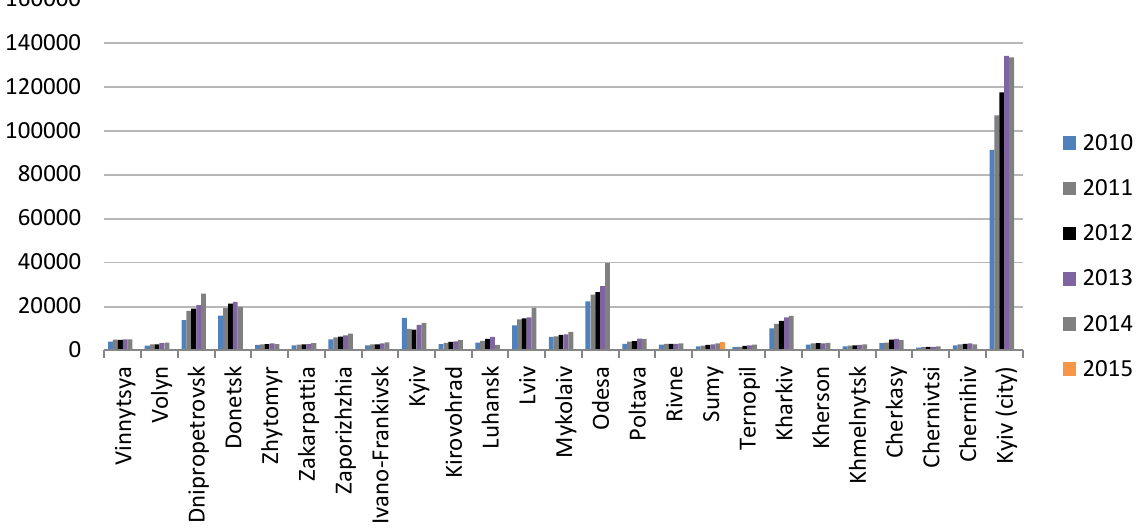
Fig. 11. The sales volume of services sector enterprises by regions in 2010 – 2015, million UAH (based on data of the State Statistics Service of Ukraine)